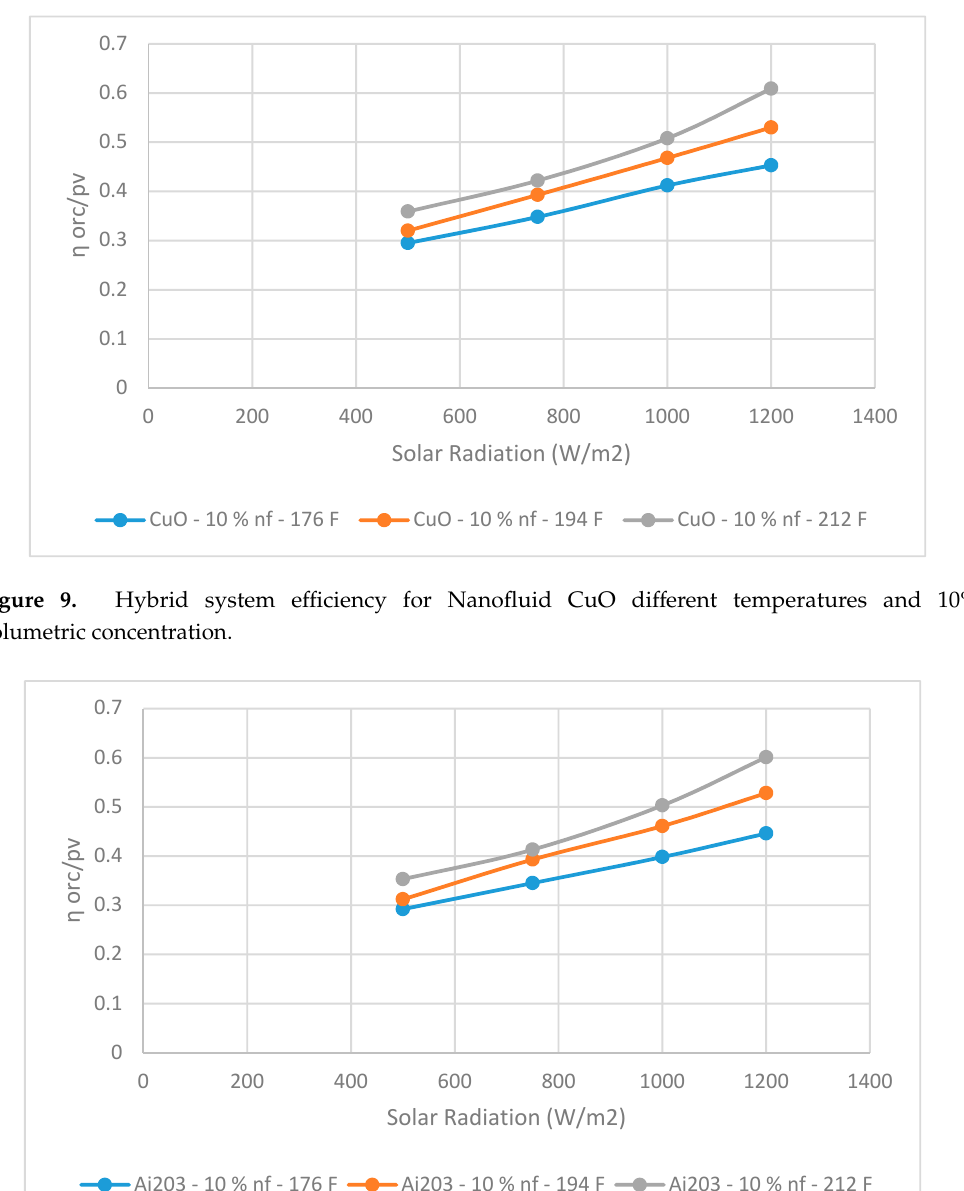
Figure 8. Hybrid system efficiency for Nanofluid Fe 3 O 4 different temperatures and 10% volumetric concentration.